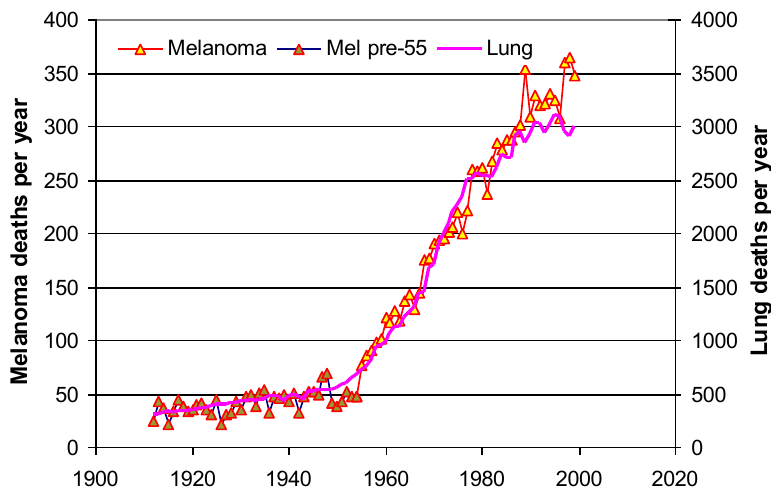
Figure 7. The number of deaths in skin melanoma and in lung cancer started to increase quite abruptly from 1955 in Sweden [5]. Data earlier than 1952 were obtained from paper files at Statistics Sweden